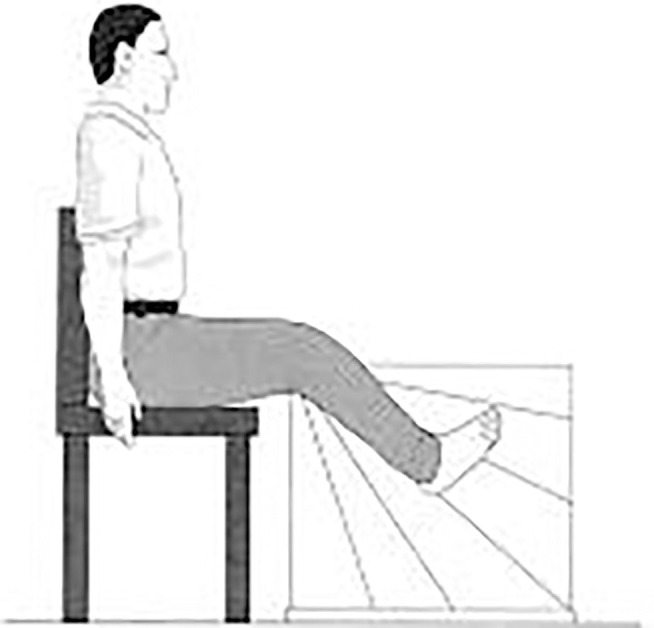
Subject matching the feet on the acrylic sheet during the proprioception test (13).